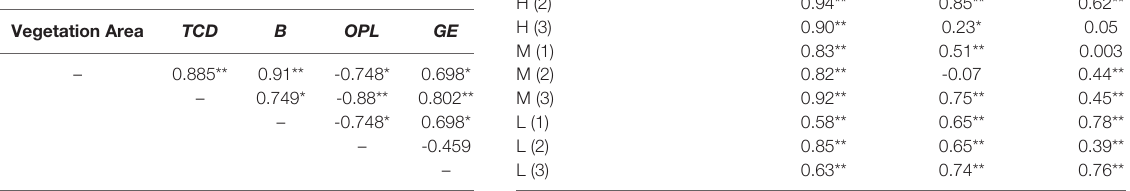
TABLE 3 | The Pearson correlations between vegetation area and tidal channel functional and geometric metrics.